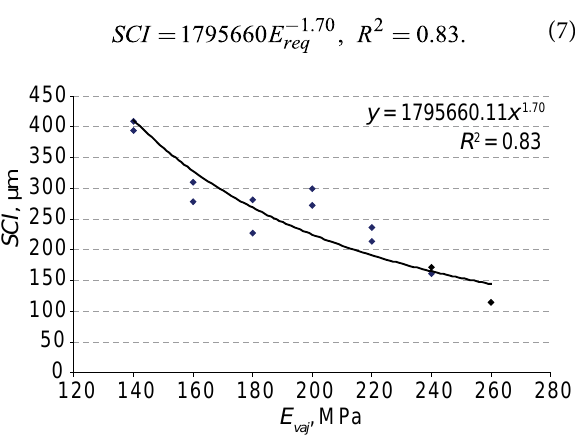
Fig. 5. SCI – E req , AC pavement on top of existing pavement